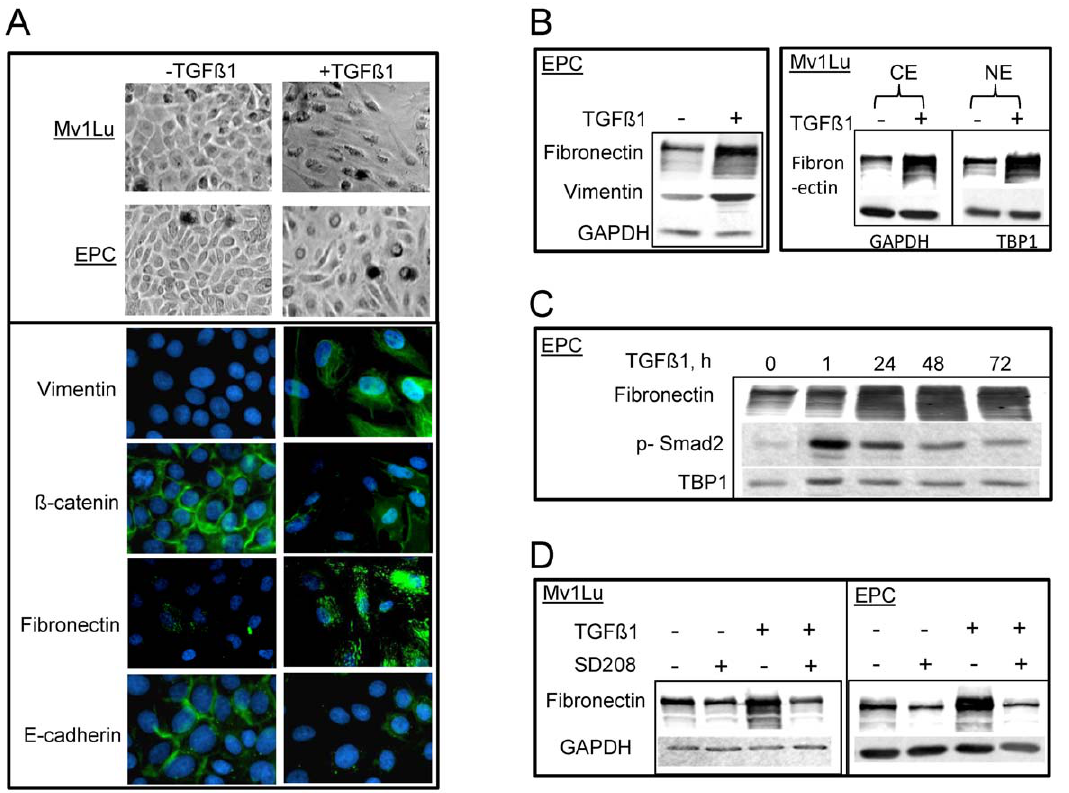
Figure 2. TGF b 1 induces EMT in both EPC and Mv1Lu cells. A. Phase contrast images of morphology alterations after TGF b 1 stimulation in EPC and Mv1Lu cells. Hallmarks for mesenchymal phenotype including vimentin, b -catenin, E-cadherin and fibronectin (green immunofluorescence) are shown in EPC cells 3 days after TGF b 1 treatment (right, lower panel). DAPI staining (blue) represents cell nuclei. B. The expression of EMT markers using western blotting from whole cells extracts in EPC cells. Right upper panel shows expression of fibronectin in both cytoplasmic extract and nuclear extract in the presence or absence of TGF b 1treatment (2 days) in Mv1Lu cells. GAPDH and TBP1 were used as loading control of cytoplasmic extract and nuclear extract, respectively. C. Expression of fibronectin and p-Smad2 in nuclear extract of EPC cells after different incubation time with TGF b 1. D. Effect of inhibition of fibronectin expression upon TGF b R1 inhibitor -SD208 treatment in both EPC and Mv1Lu cells. Whole cell extracts were used for western blotting. Other details were shown in Figure 1.